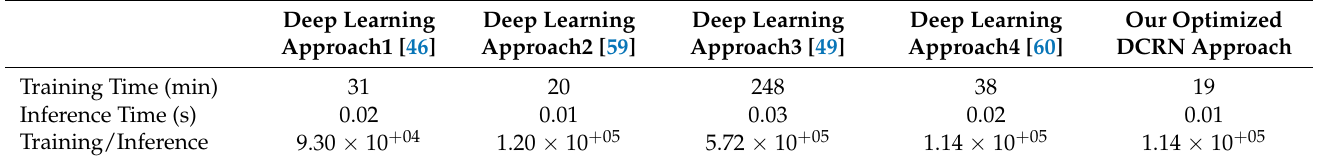
Table 8. Our proposed DCRN approach for building orientation angle estimation processing time results vs. the previous deep learning methods.